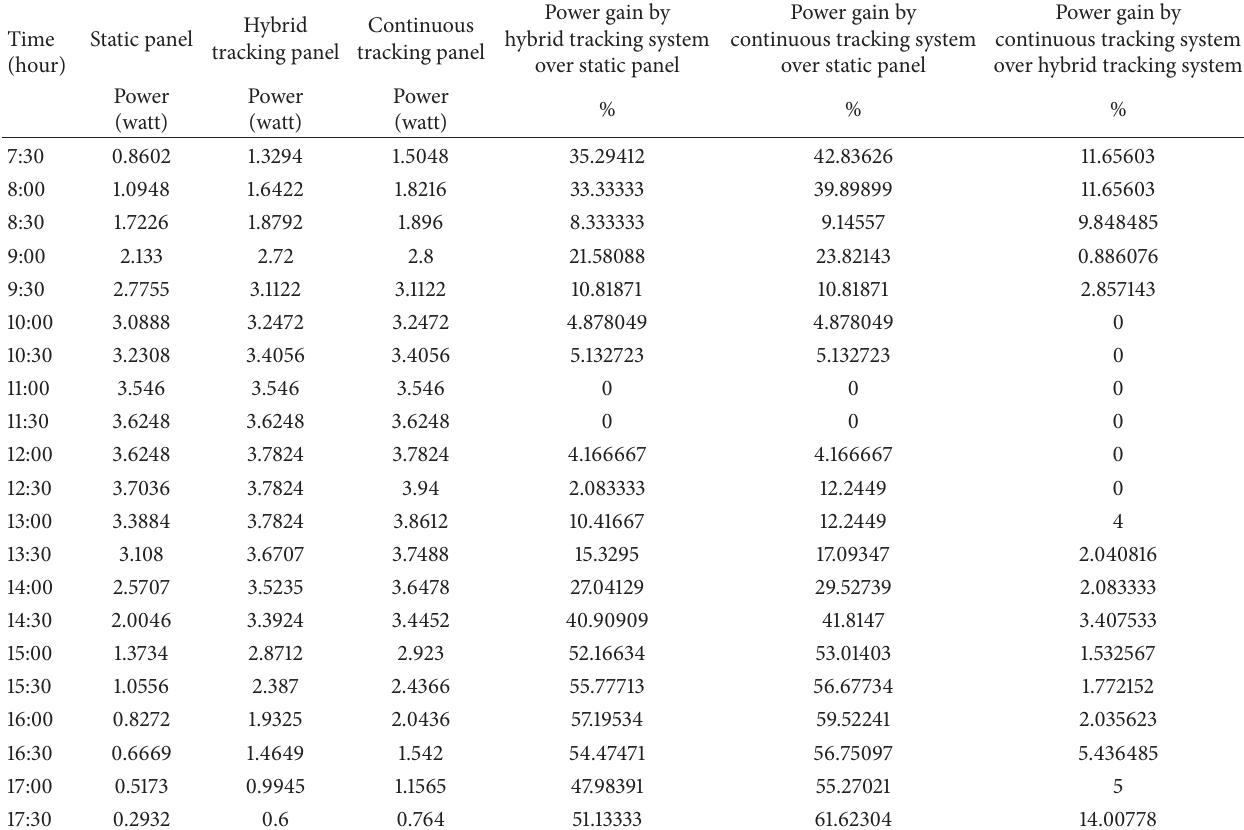
Table 3: Power values of static and tracking panel and the corresponding power gain by tracking panel over static panel at different times in a